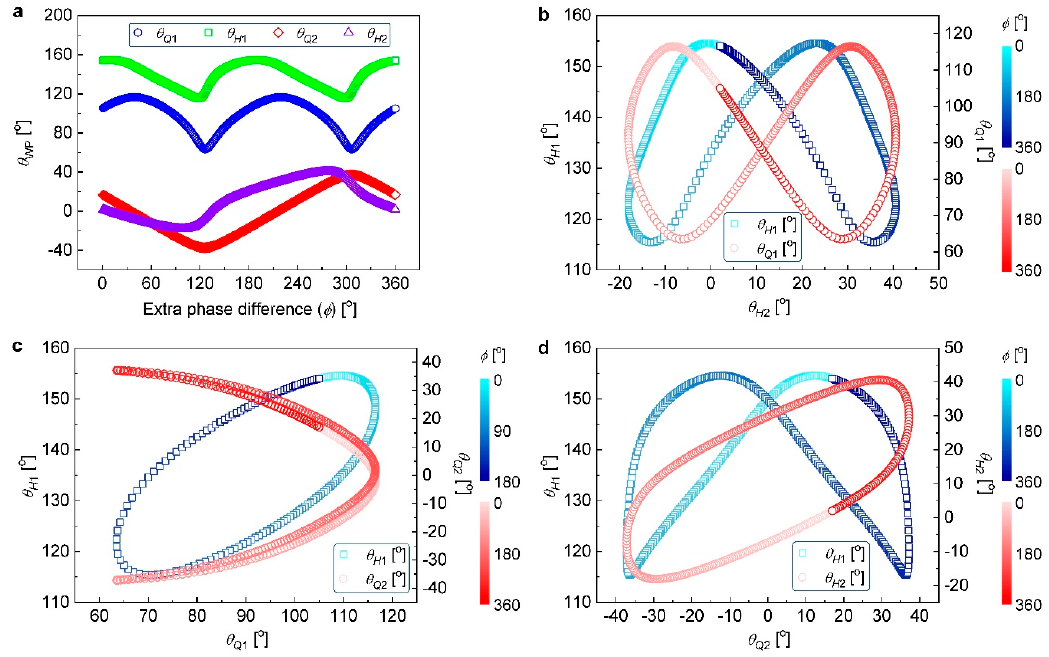
Figure 4. ( a ) Four WOA’s θ Q 1 (blue circles), θ H 1 (green squares), θ Q 2 (red diamonds), and θ H 2 (violet triangles) as a function of extra phase difference ϕ (from 0° to 360° with a step of 1°) for phase modulation of another GTF ( t GTF 2 ) at θ P 1 = 0° and θ P 2 = 22.5°. ( b ) Loci of ( θ H 2 , θ H 1 ) and ( θ H 2 , θ Q 1 ), displayed by blueish squares and reddish circles, respectively. ( c ) Loci of ( θ Q 1 , θ H 1 ) and ( θ Q 1 , θ Q 2 ), indicated as blueish squares ( ϕ : 0° – 180°) and reddish circles ( ϕ : 0° – 360°), respectively. ( d ) Loci of ( θ Q 2 , θ H 1 ) and ( θ Q 2 , θ H 2 ), displayed by blueish squares and reddish circles, respectively.